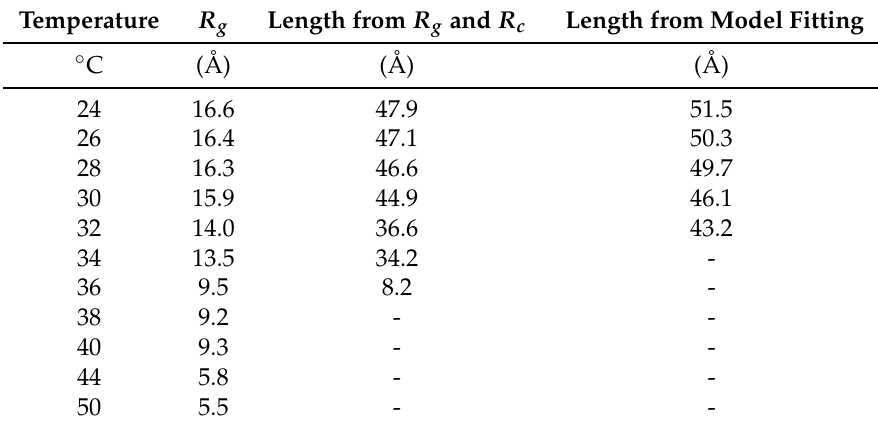
Table 5. Temperature dependence of R g s and particle length for GMPNa 2 50 mg/mL in 0.5 M KCl. Errors are in the order of